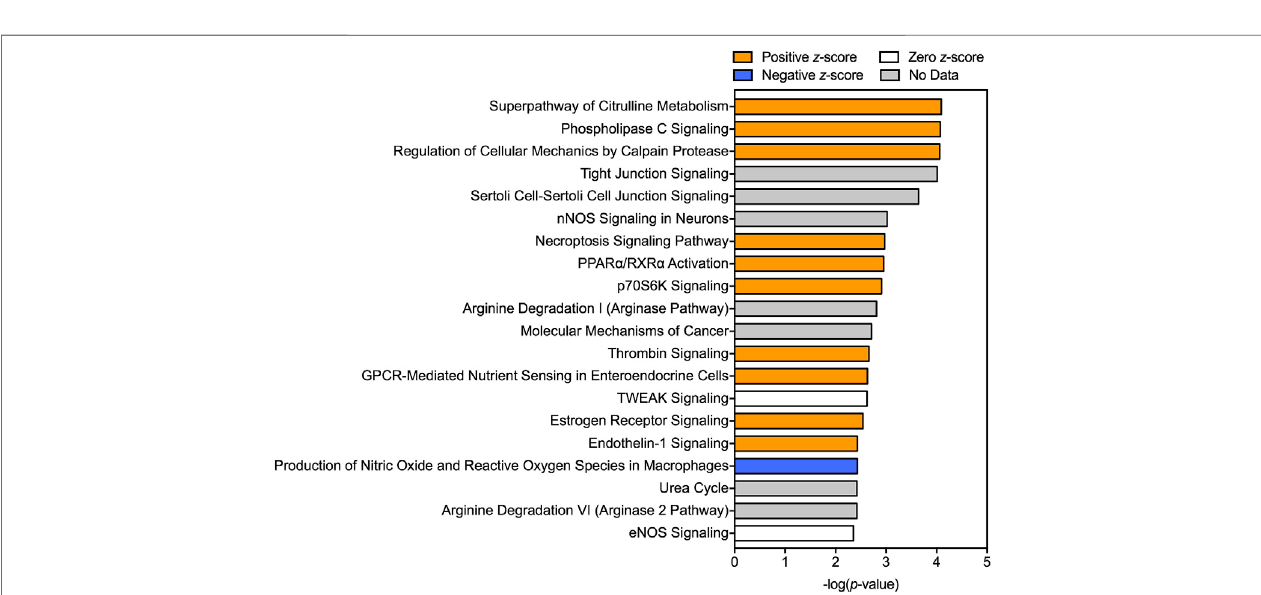
FIGURE 4 | Top canonical pathways predicted by Ingenuity Pathway Analysis (IPA) to be affected following dilbit exposure. A positive z -score indicates predicted activation whereas a negative z -score indicates a predicted inhibition.